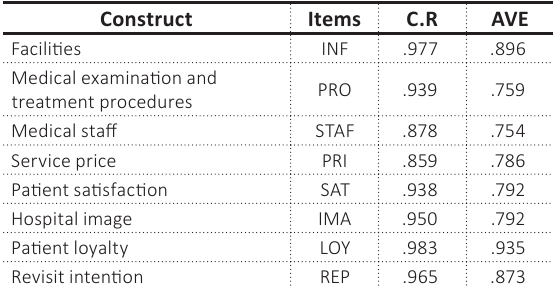
Table 4. Result of composite reliability and average variance extracted testing